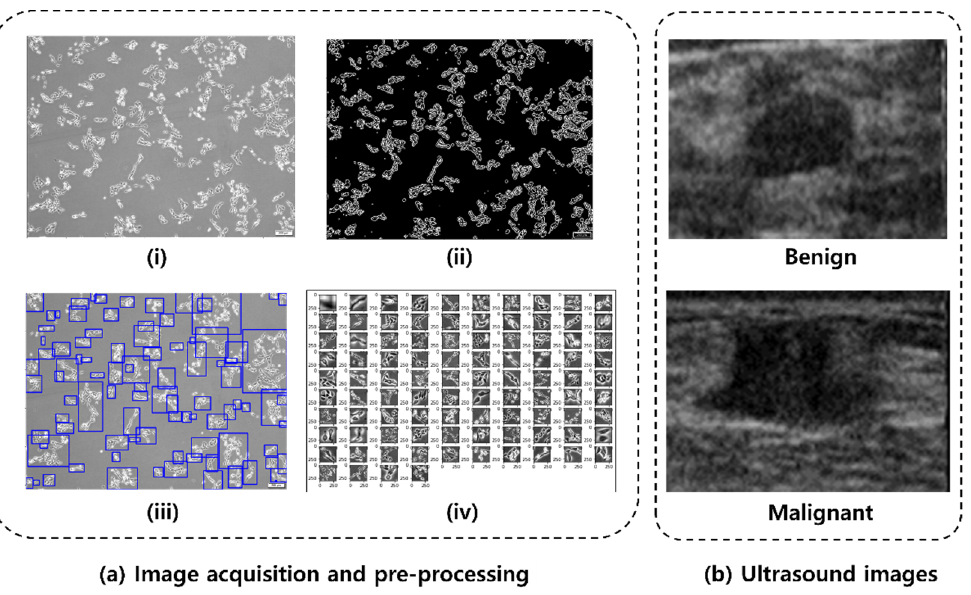
Figure 2. ( a ) Cancer cell images acquisition and pre-processing: ( i ) acquired HeLa cell image, ( ii ) binary image, ( iii ) image segmentation, and ( iv ) extracted image for training. ( b ) Representative Mendeley breast ultrasound images.